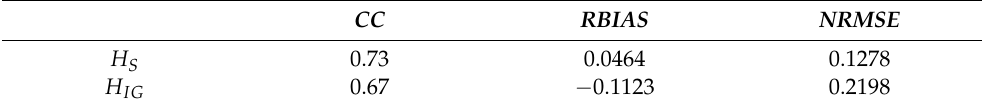
Figure 4. Modeled (red) and observed (black) wave heights 1–25 September 2018, at the location of sensor G1: ( a ) significant wave height H S and ( b ) significant IG wave height H IG . Table 2. Performance statistics of XB-SB at the location of sensor G1.